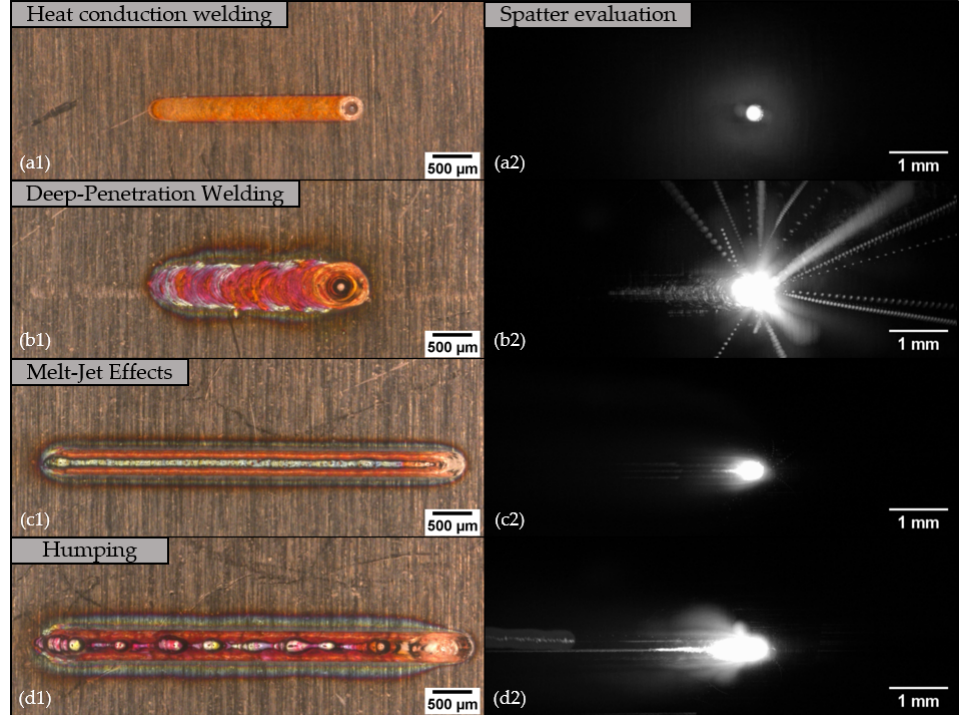
Figure 2. Exemplary weld seams to illustrate the criteria used for the assessment, as well as su- perimposed images of the high-speed-imaging, for determining the spatter occurrence in the laser process. ( a1 , a2 ) heat conduction welding ( P = 1000W, v = 250 mm ); ( b1 , b2 ) deep-penetration weld- s ing ( P = 1500W, v = 250 mm ); ( c1 , c2 ) deep-penetration welding with melt jet effects ( P = 1750W, s ), ( d1 , d2 ) deep-penetration welding with humping ( P = 3000W, v = 750 mm v = 750 mm s s